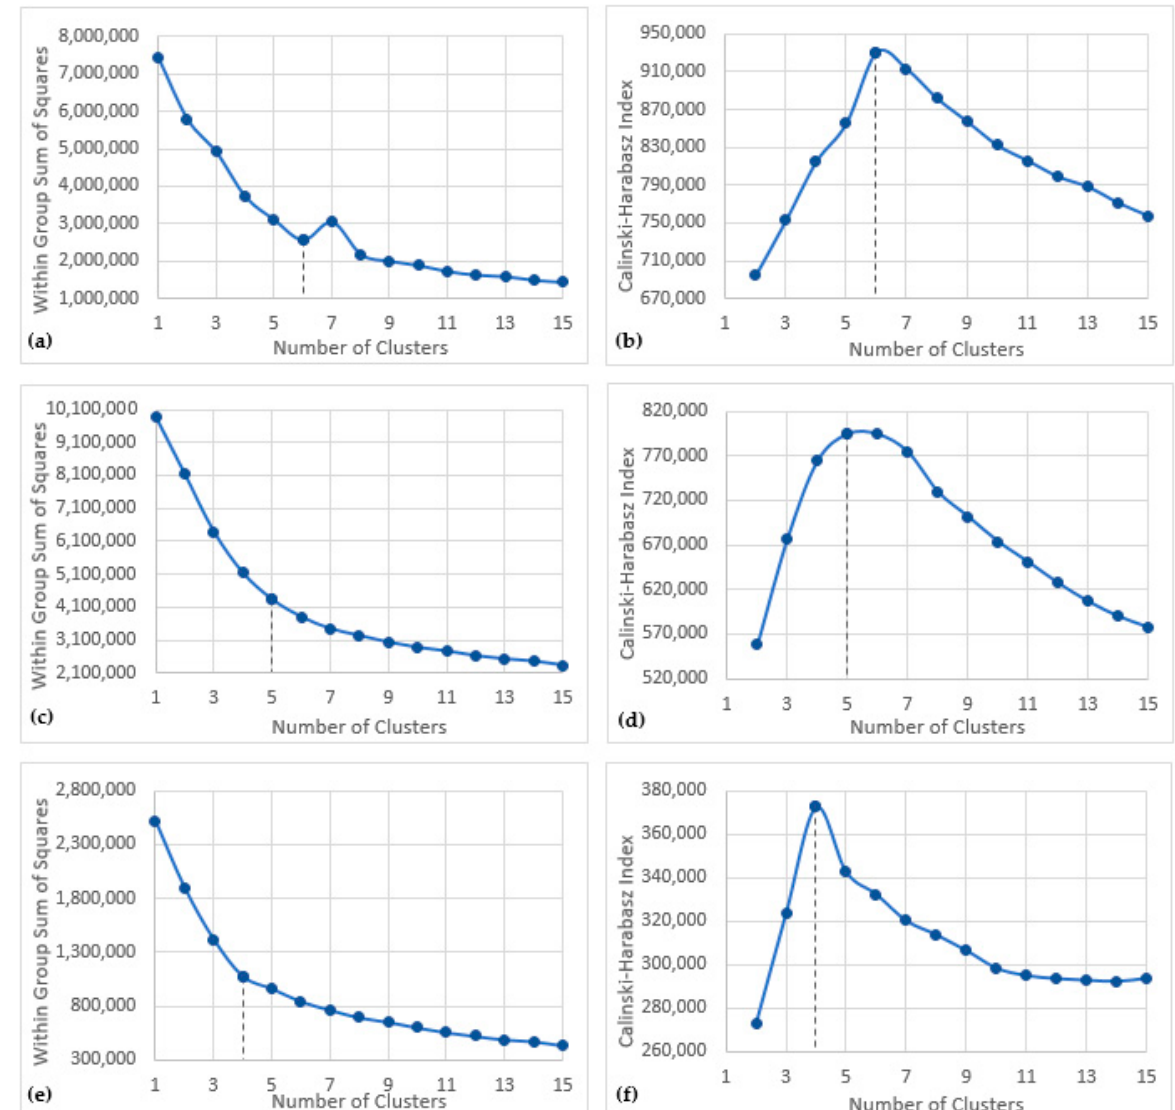
Figure 2. Optimal K-means cluster solution for each study area. Showing ( a ) number of clusters versus the within group sum of squares for the larger study area, using three eigenvalues; ( b ) number of clusters versus the Calinski-Harabasz criterion for the larger study area, using three eigenvalues; ( c ) number of clusters versus the within group sum of squares for the larger study area, using four eigenvalues; ( d ) number of clusters versus the Calinski-Harabasz criterion for the larger study area, using four eigenvalues; ( e ) number of clusters versus the within group sum of squares for the smaller study area; ( f ) number of clusters versus the Calinski-Harabasz criterion for the smaller study area.